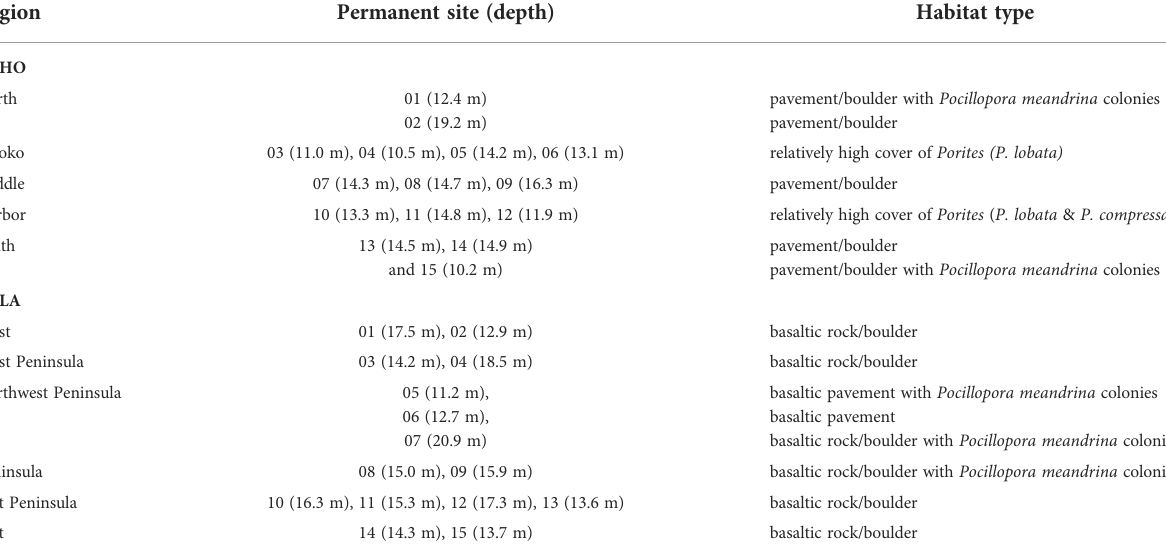
TABLE 1 Grouping and water depths of KAHO and KALA permanent survey